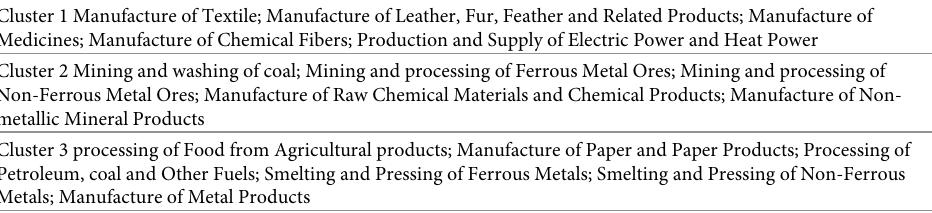
Table 4. Clustering division of 16 heavy polluting